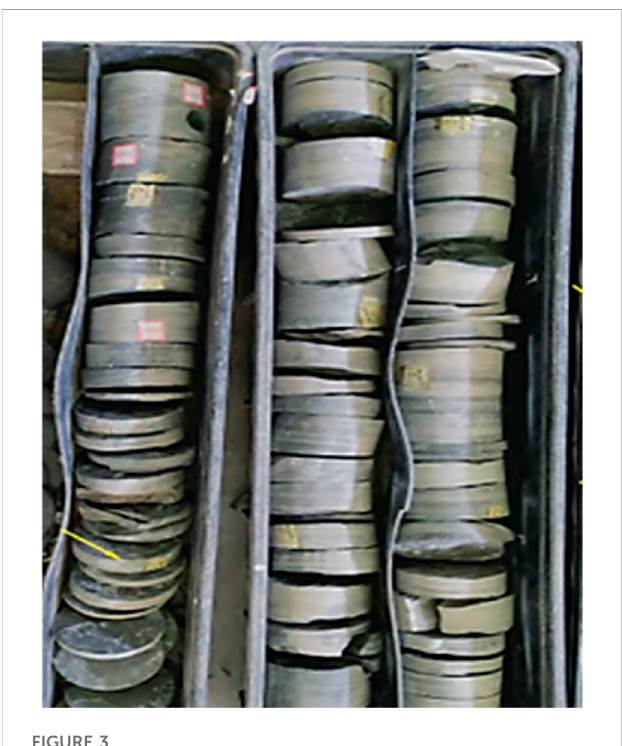
FIGURE 3 Partial photos of the